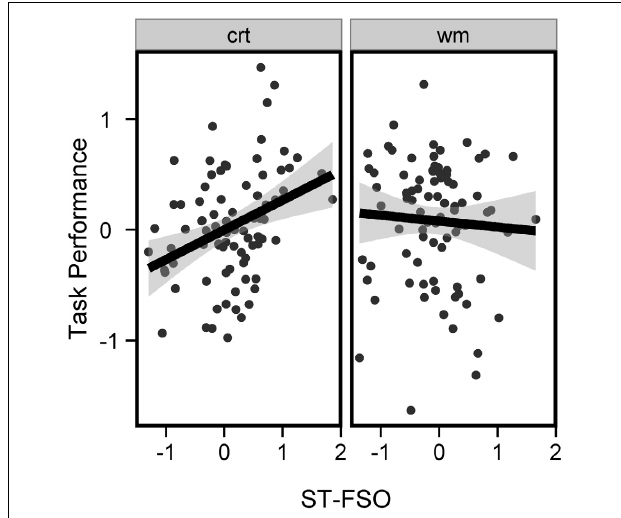
FIGURE 6 | Link between SGT and cognitive tasks performance. Task performance was plotted against the ST-FSO Score for each subject, separately for each cognitive task. Increase in ST-FSO was associated with increased performance during the CRT task (left panel, p < 0 . 07) but had no significant effect in the WM task (right panel). Black lines represent best-fitted linear regressions and gray areas represent 95% confidence